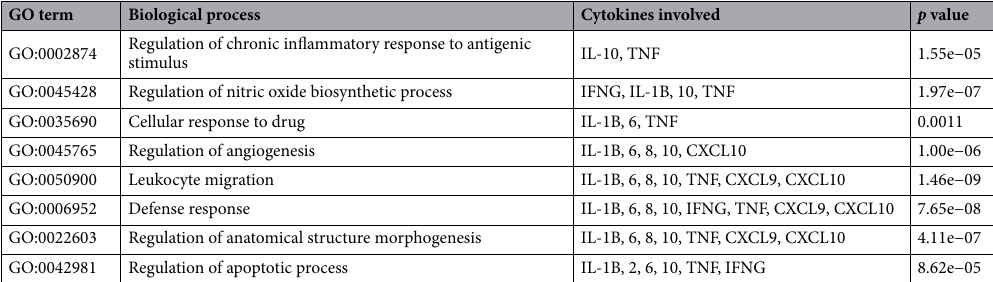
Table 3. This table illustrates the significantly altered cytokines and the biological processes which correlates with the clinical ocular condition of chronic SJS